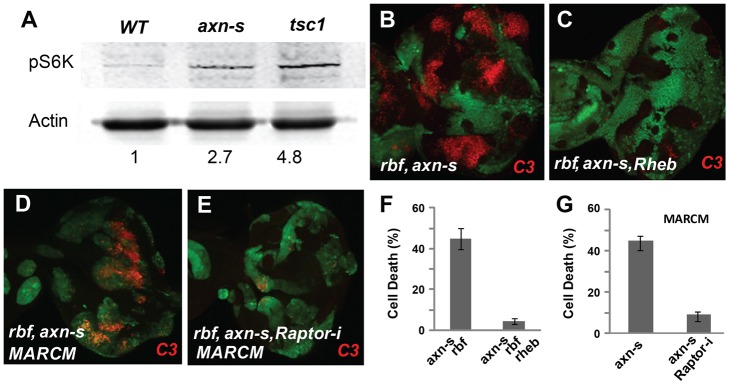

axn rbf synergistic cell death is mediated by deregulation of mTOR activities.pS6K signal was used to detect mTOR activities. FRT 82B WT control, axnS and tsc1 mutant eye discs were generated by inducing clones in Minute background. pS6K in axnS mutant eye discs was increased and similar to that in tsc1 mutant eye discs (A). Rheb mutation blocked apoptosis in rbf axnS mutant cells (B, C). Knockdown of Raptor by RNAi (Raptor-i) rescued rbf axnS cell death (D–E). Quantification of C3 levels in (B–C and D–E) was shown in panel (F) and (G) respectively.